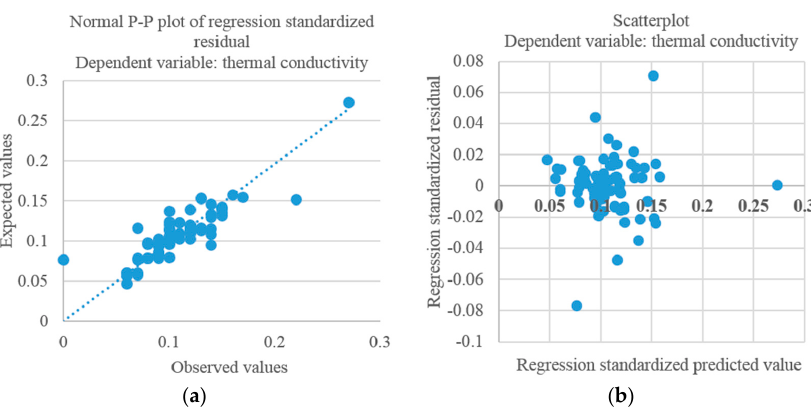
Figure 3. Normal probability plot of residuals for Model 1 (thermal conductivity). ( a ) Normal P-P plot of regression standardized residual; ( b ) Scatterplot.